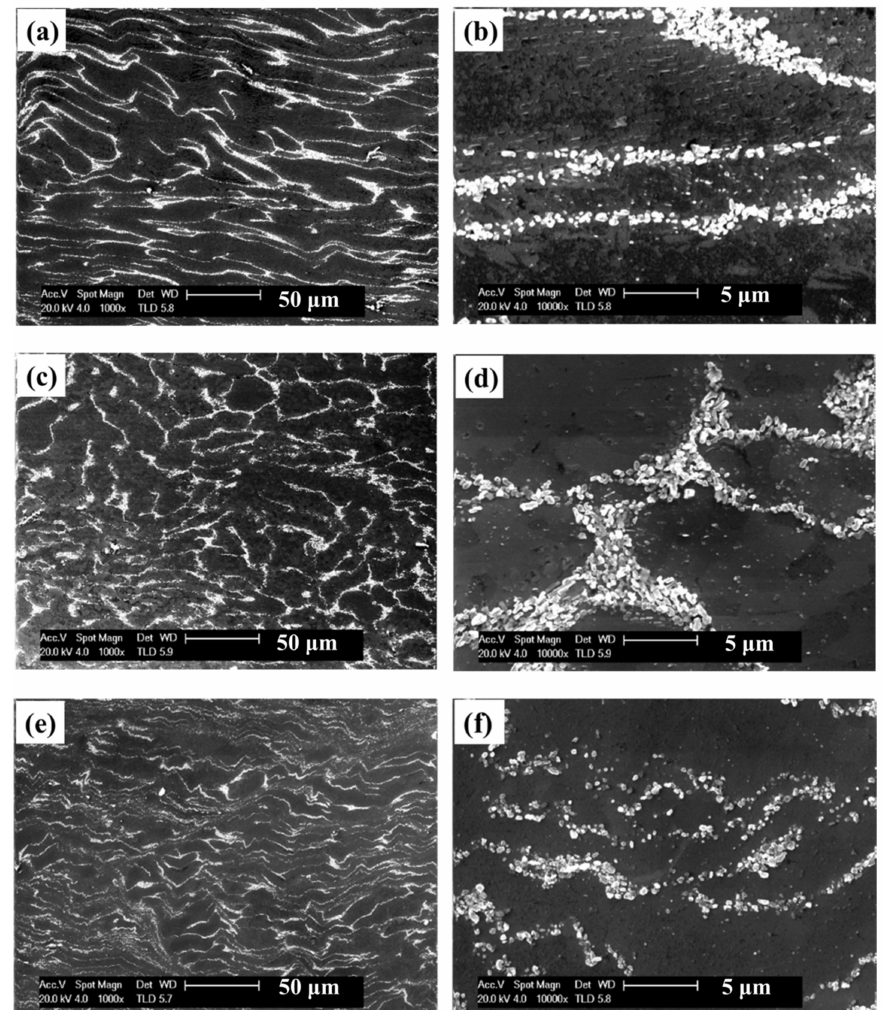
Figure 4. SEM images of ECAP alloys processed at ( a , b ) 623 K-4P, ( c , d ) 623 K-12P and ( e , f ) 573 K-12P with ( a , c , e ) low and ( b , d , f ) high